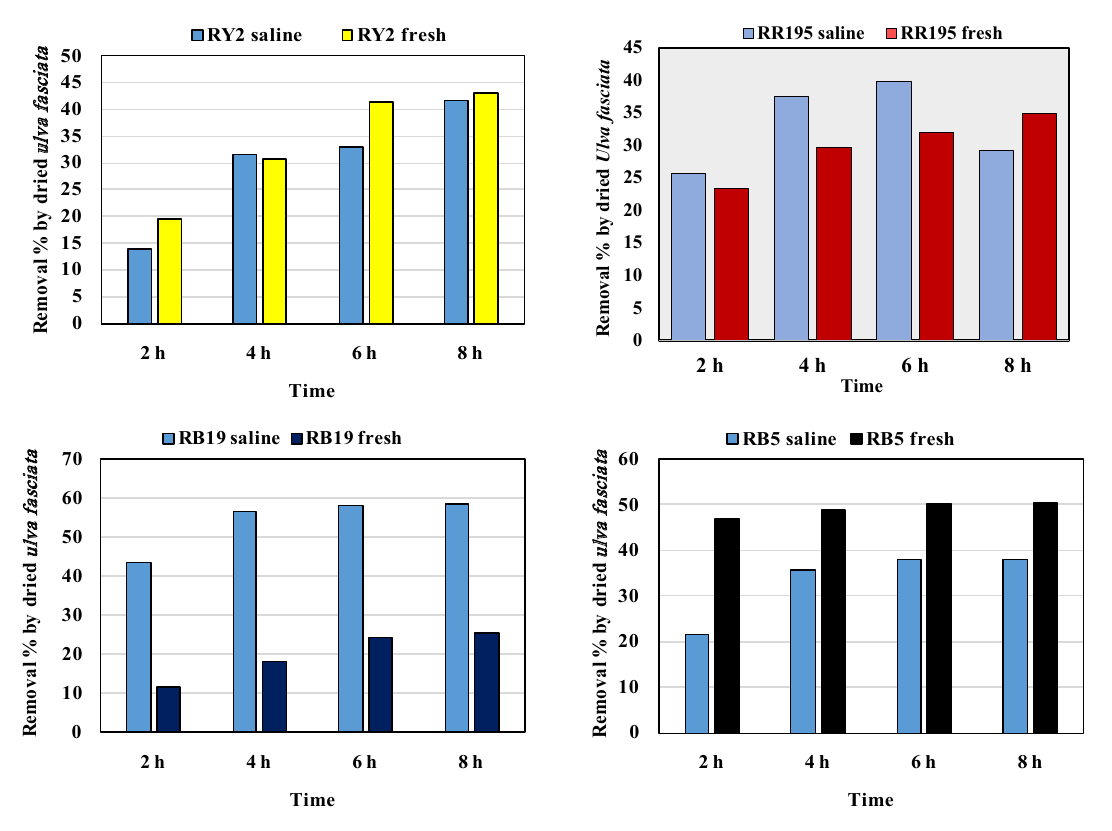
Fig. 11 Removal percentages of the four studied dyes by dried Ulva fasciata under saline and fresh conditions Table 12 Removal percentages of the four studied dyes by dried Pterocladia capillacea under saline and fresh